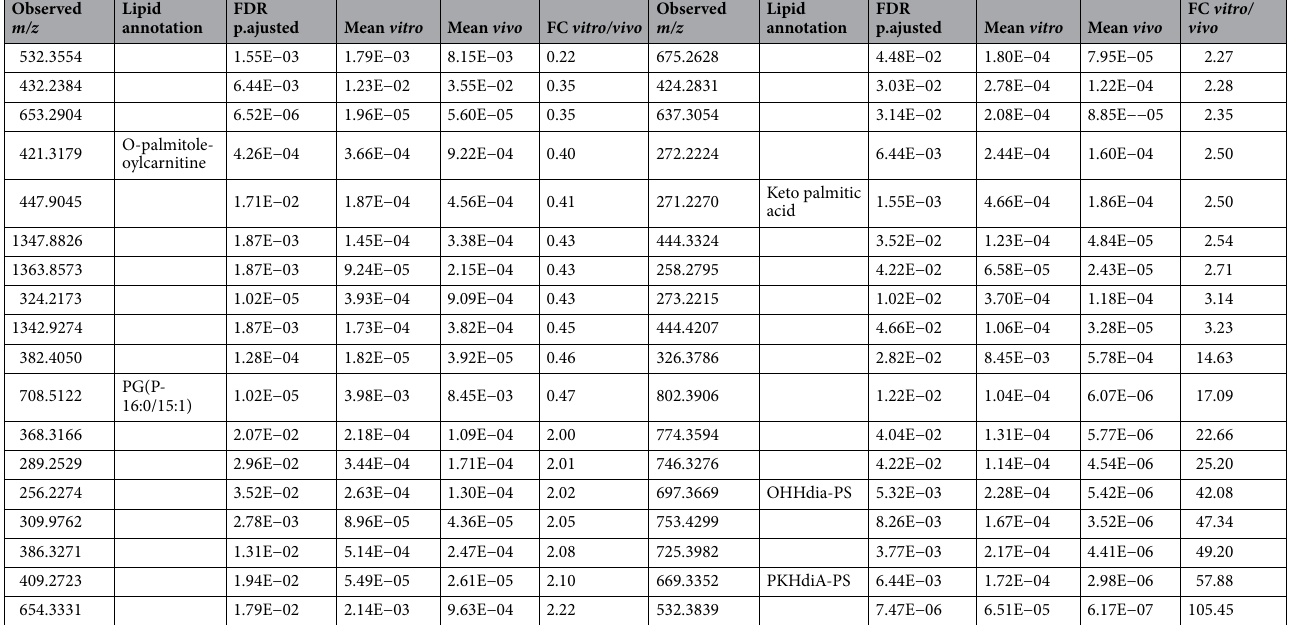
Table 2. Differentially expressed lipids between in vitro and in vivo produced embryos. In this table only the 39 most different lipids among the 105 different lipids with FC > 1.5 or < 0.66 were presented. p values with FDR (false discovery rate) are presented here. The complete table with all the significant features and lipid annotation is provided in Supplementary Table